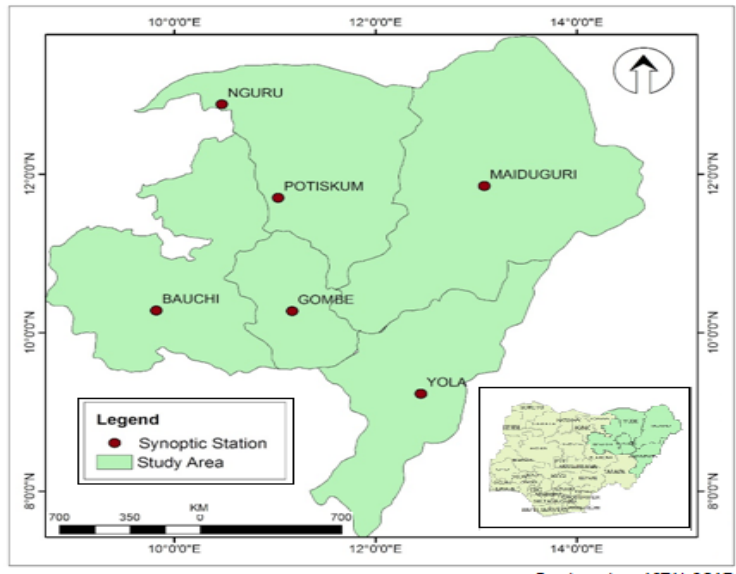
Figure 1: A map showing the study area including the six synoptic stations (Source: Danlami et al .,